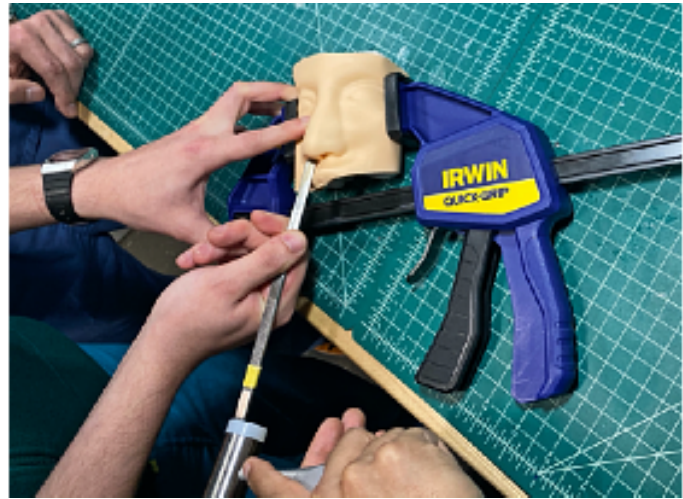
Figure 7. Use of simulation